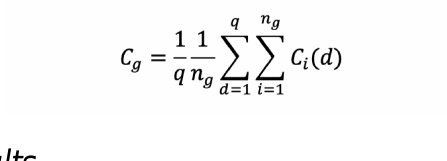
Figure 4. Compliance of one user on a specific day.